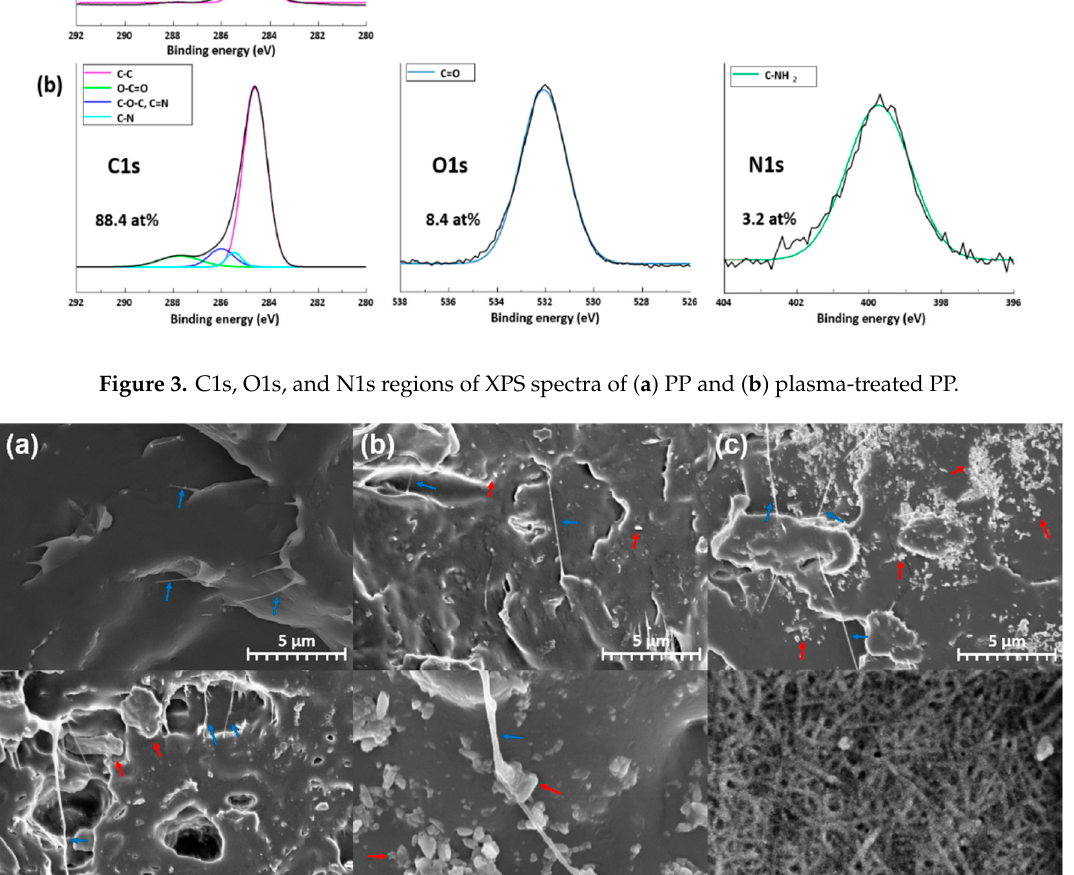
Figure 3. C1s, O1s, and N1s regions of XPS spectra of (a) PP and (b) plasma-treated PP.